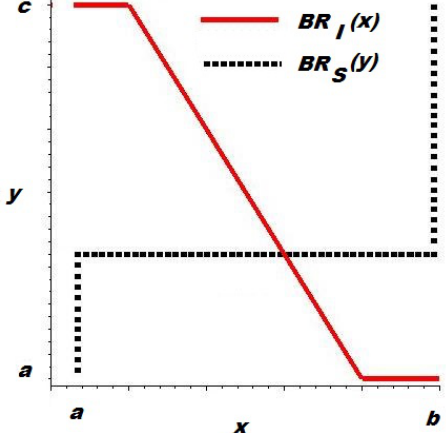
Figure D.1. The Nash equilibrium as an intersection of the best response